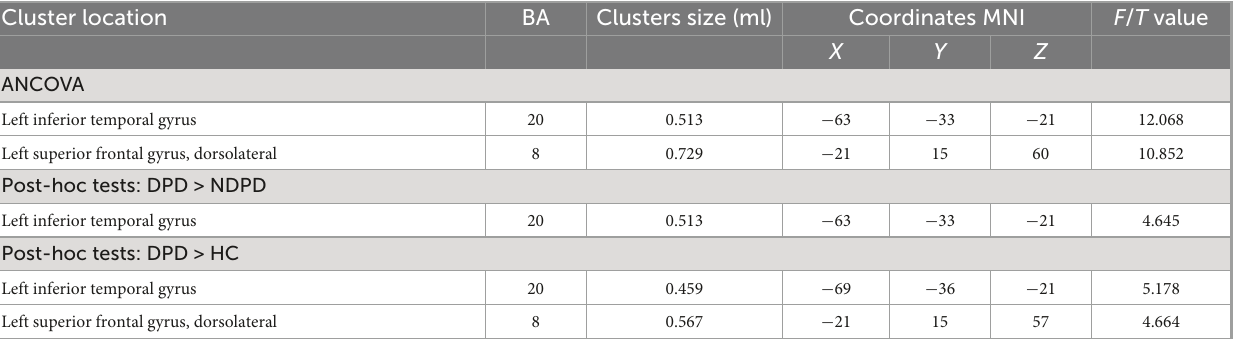
TABLE 3 The differences of DC among three groups.